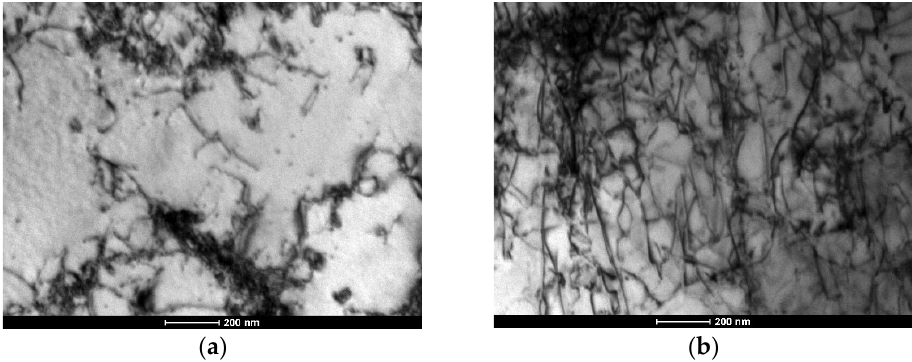
Figure 11. TEM micrographs showing dislocation structure of Fe in annealed state ( a ) without hydrogen ( b )